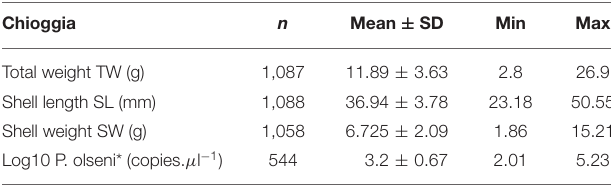
* Descriptive statistics for this trait are shown only for the 544 samples that contained quantifiable amounts of P. olseni DNA ( > LOQ).